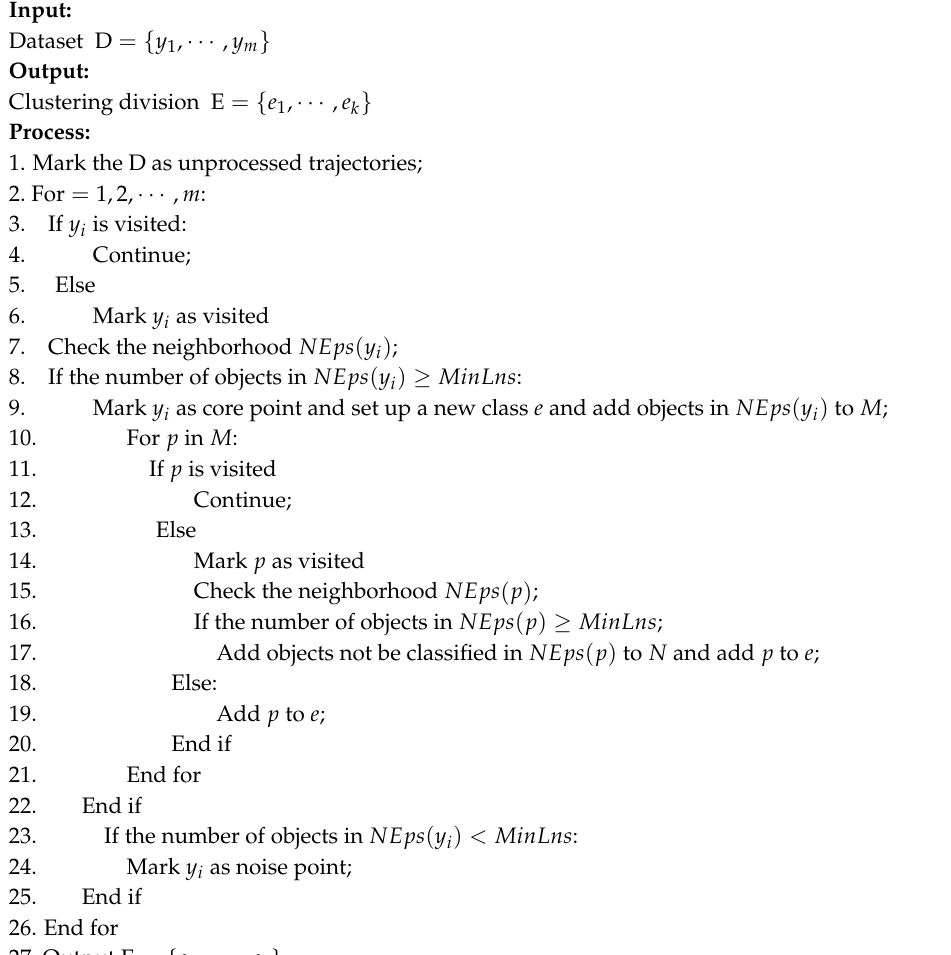
Algorithm A2 DBSCAN Algorithm for trajectories